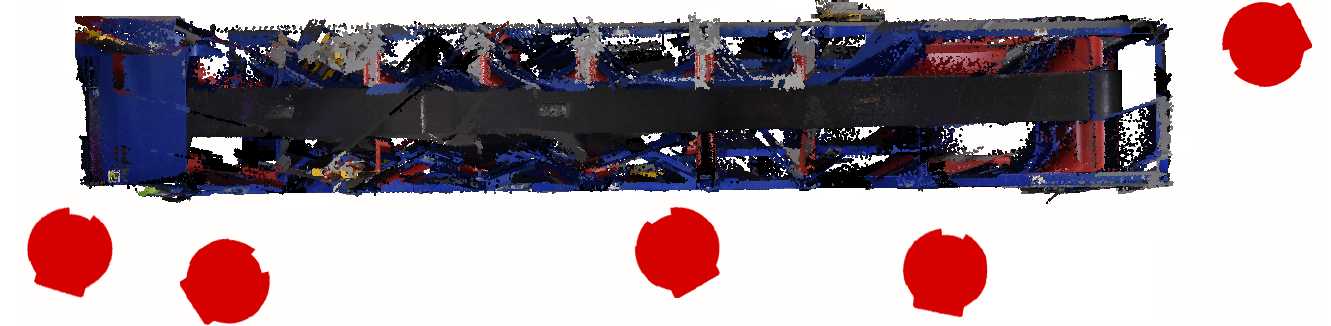
Figure 9. TLS locations during the test